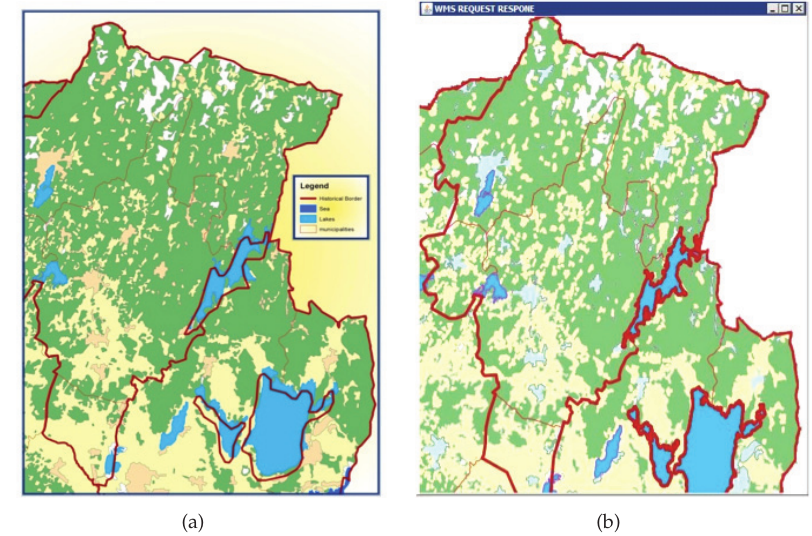
Figure 9: (a)Visualization of the original digitalized historical borders. (b) Output from the cartographic enhanced